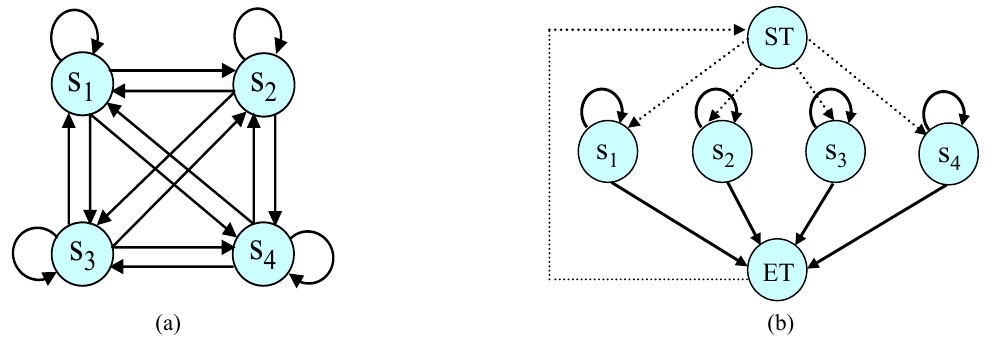
Figure 7. ( a ) An ergodic model and ( b ) a simplified ergodic model with fewer transitions and two dummy